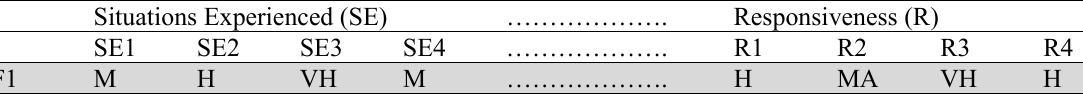
Table 3 Showing the initially assigned weight from Firm 1 Situations Experienced (SE)